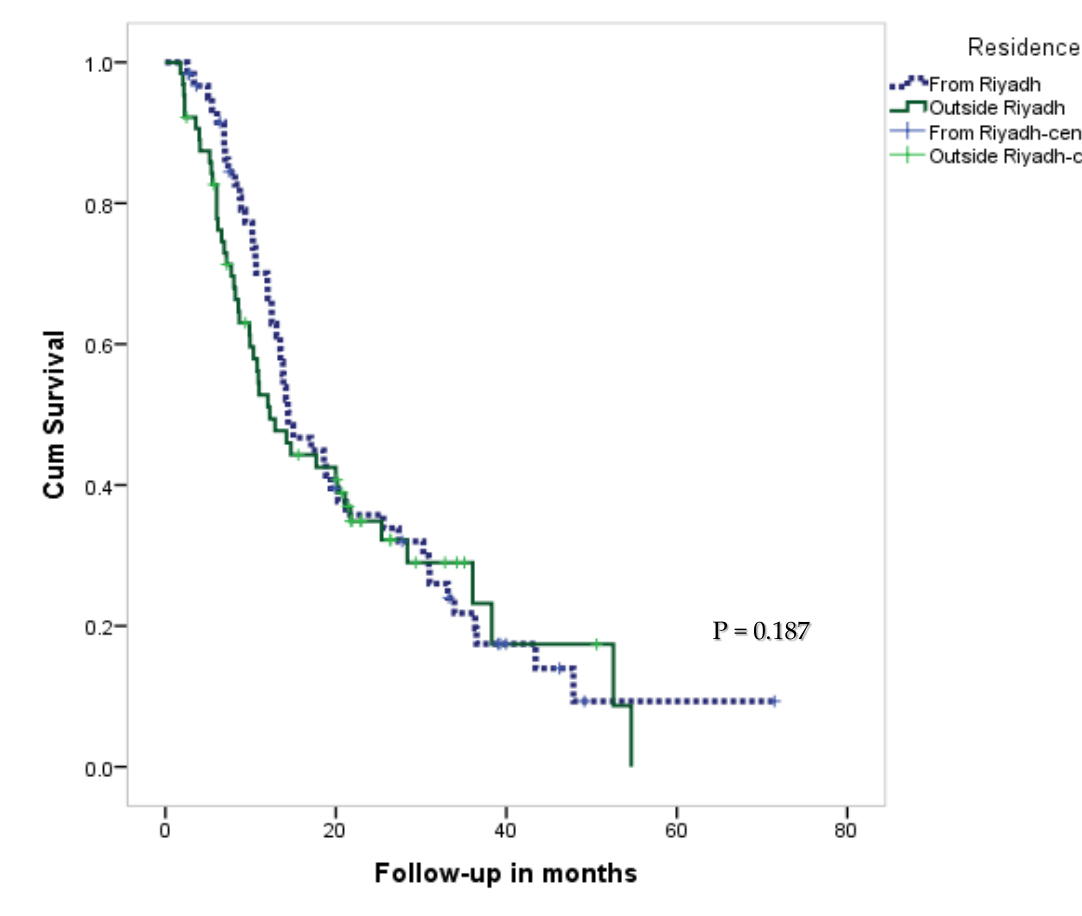
Figure 1. KM curve of survival rate for patients with GBM, by their residence.